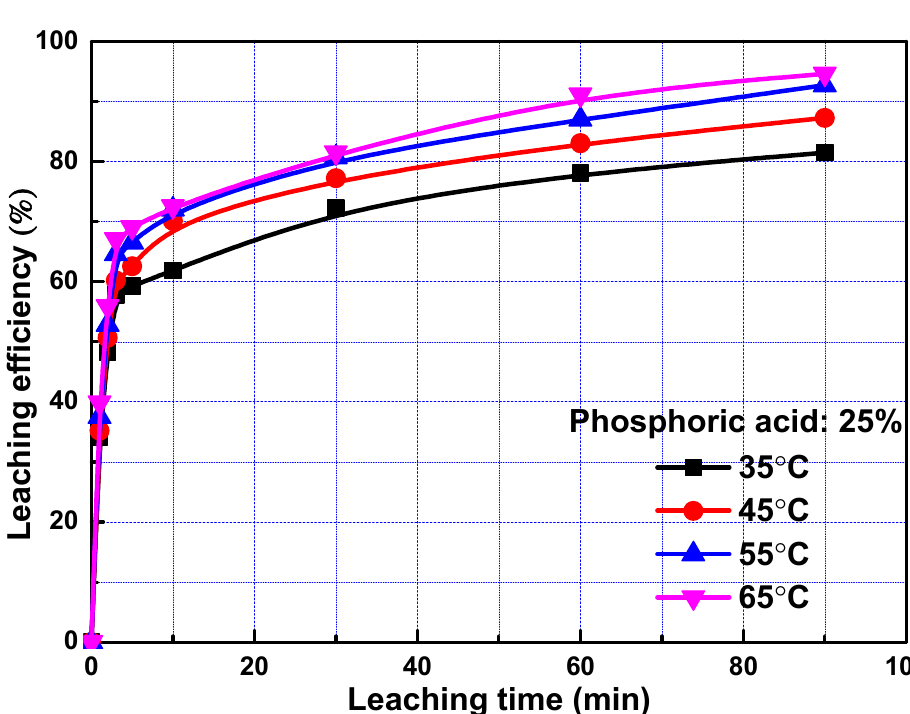
Figure 2. Leaching efficiency of rare earth elements (REEs) as a function of time at different temperature.